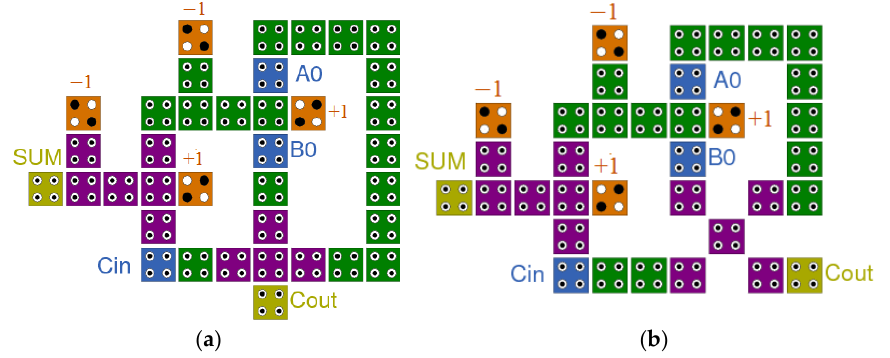
Figure 5. The QCA layout with ( a , b ) FA circuits.